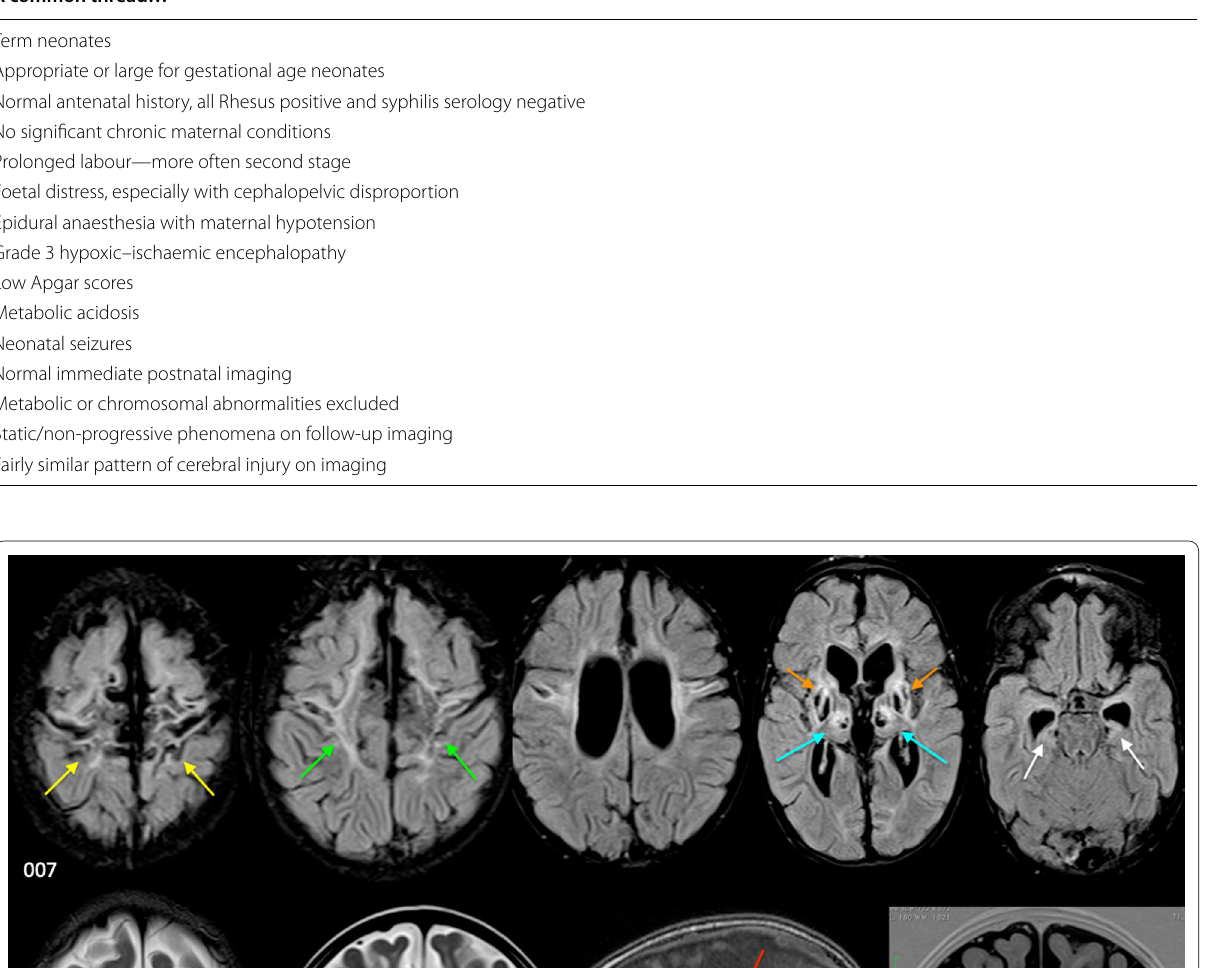
difference compared to those in the MPI subgroup, with p values < 0.001. Statistically significant differences were also found in the injuries identified in the hippocampi ( p 0.006), thalami ( p 0.002), putamina ( p < 0.01), and = =